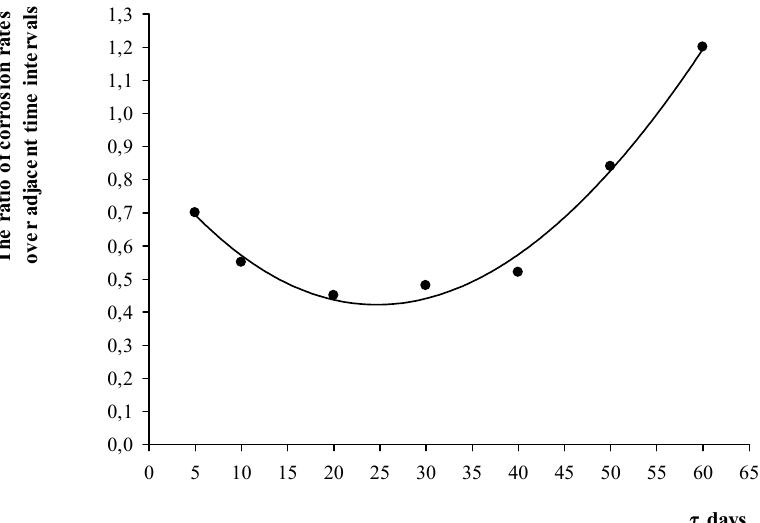
Figure 4. The history of steel grade St3 (sample No. 1) corrosion rate in the NaCl-containing solution, determined by iron availability in the saline solution with agitation.